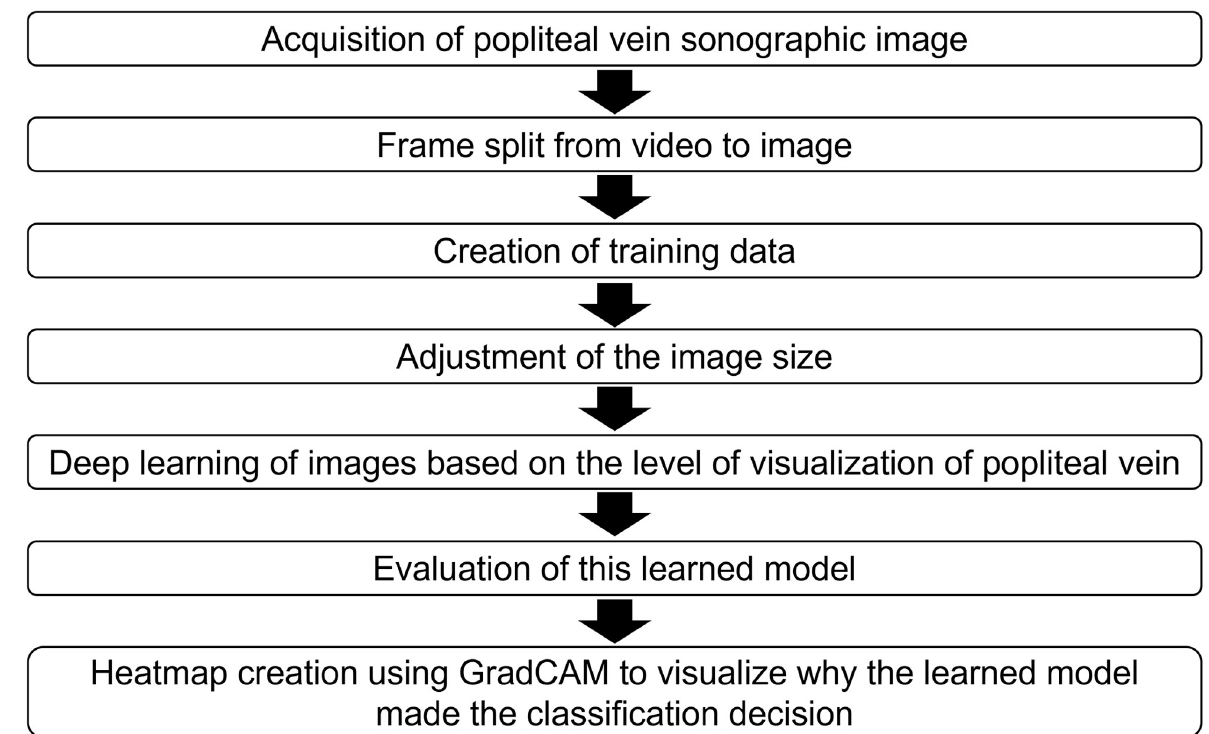
Fig 1. Overall scheme of the pre-processing and deep learning and its evaluation